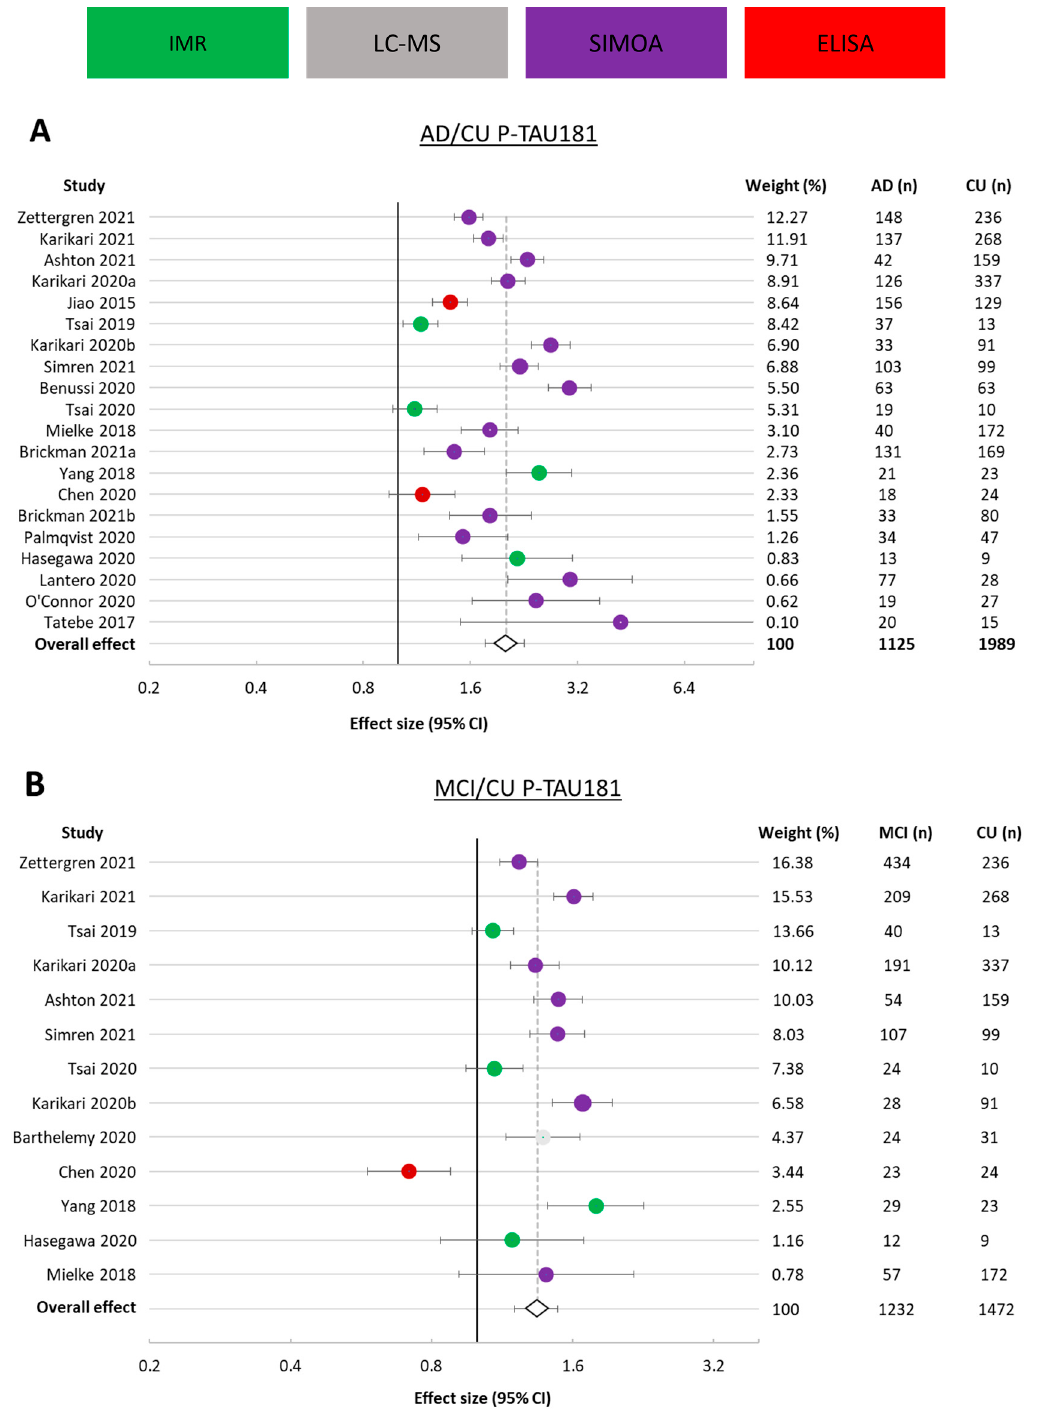
Figure 2. Forest plots for studies presenting plasma/serum p-tau181. ( A ). Alzheimer’s disease (AD) versus cognitively unimpaired (CU) participants. ( B ). Mild cognitive impairment (MCI) versus cognitively unimpaired (CU) participants. Ratio (effect size) and 95% CI for individual studies are presented by a circle, color-coded by assay type; the overall ratio is presented by a diamond and a grey vertical line. Studies are arranged in descending weight order. Data are presented on a log scale. An effect size of 1 indicates equal biomarker concentrations in AD and CU. Percentage weight, number of AD participants, and number of CU participants are displayed on the right side of the forest plot for each study and the combination of all studies. AD: Alzheimer’s disease; CU: cognitively unimpaired; CI: confidence